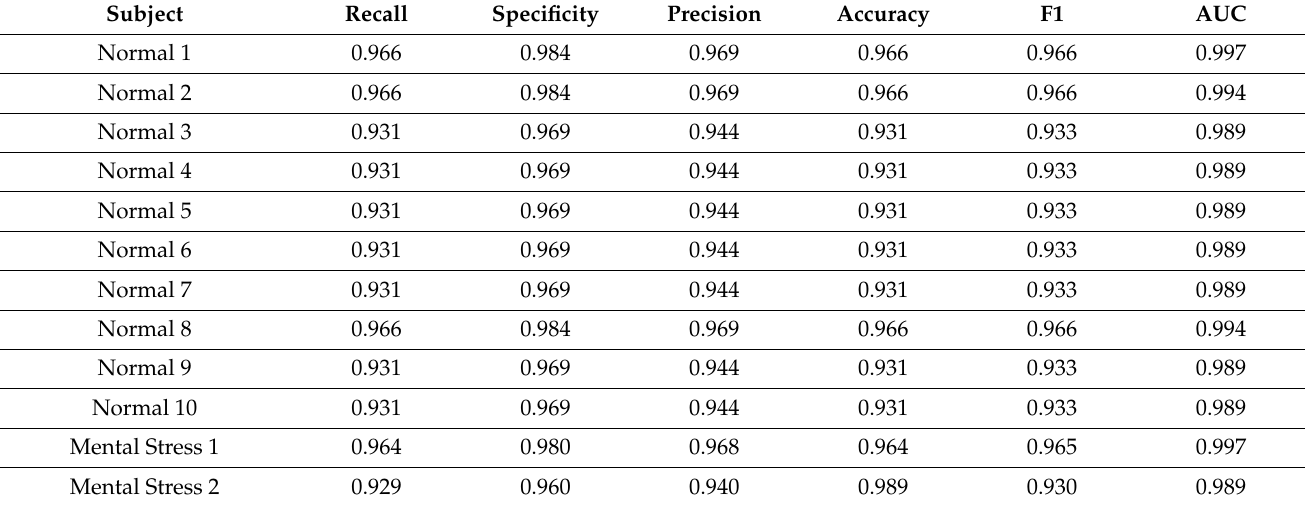
Table 4. Performance of the inter-subject (subject-wise) classification using DT classifier for the leave leave-one-out